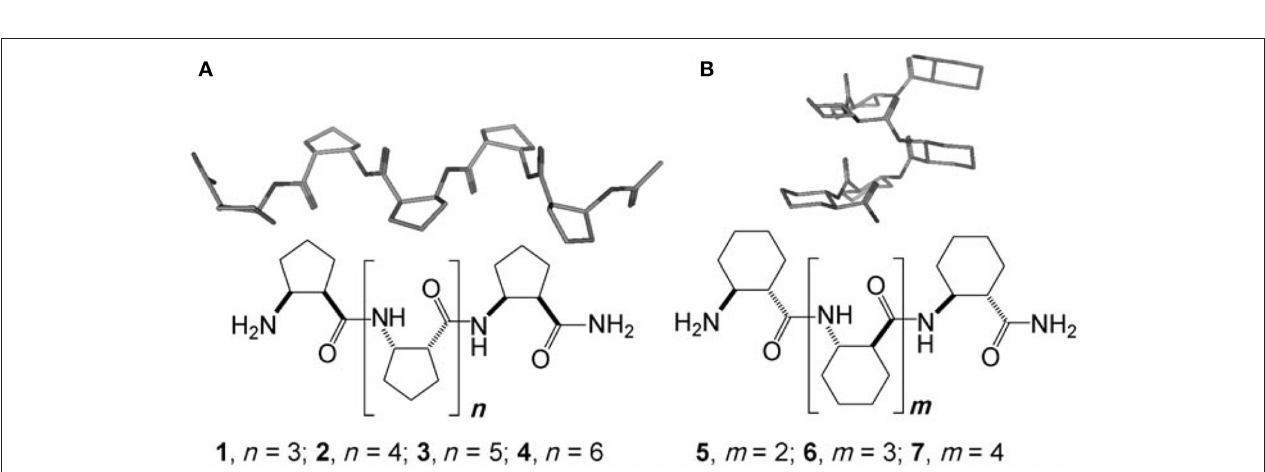
FIGURE 4 | Chemical structures and the secondary structures of (A) cis -ACPC n (1–4) and (B) trans -ACHC m (5–7) homooligomers. Reproduced with permission from Martinek et al. (2006). Copyright 2006 John Wiley & Sons.